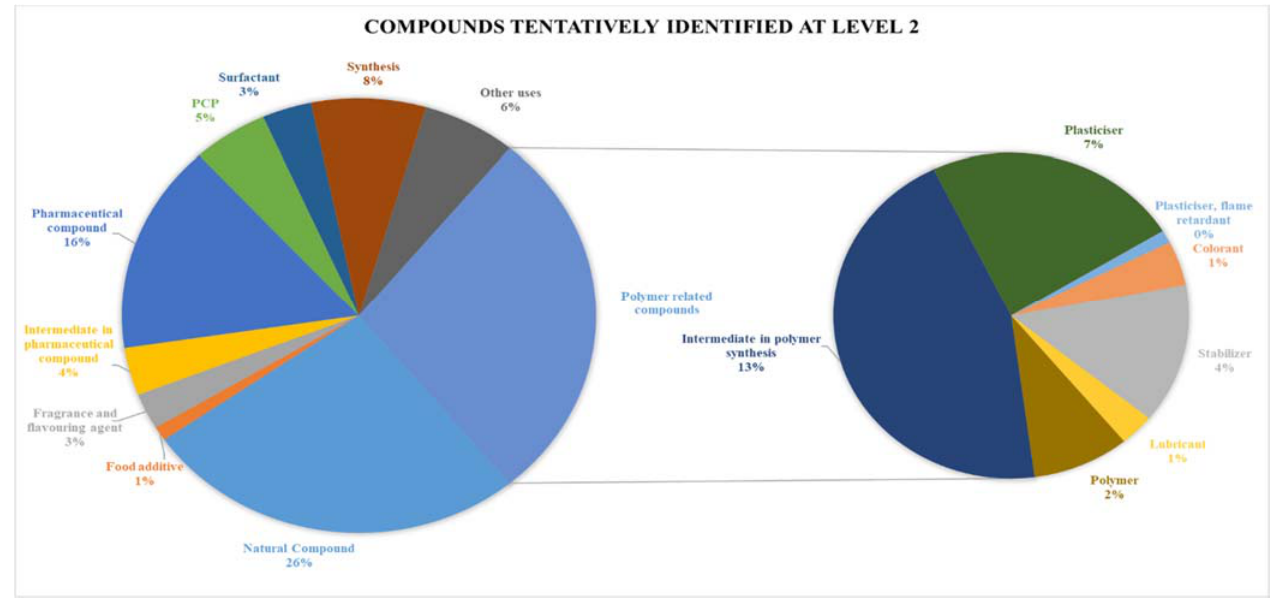
Figure 4. Compounds and plastic additives classification.